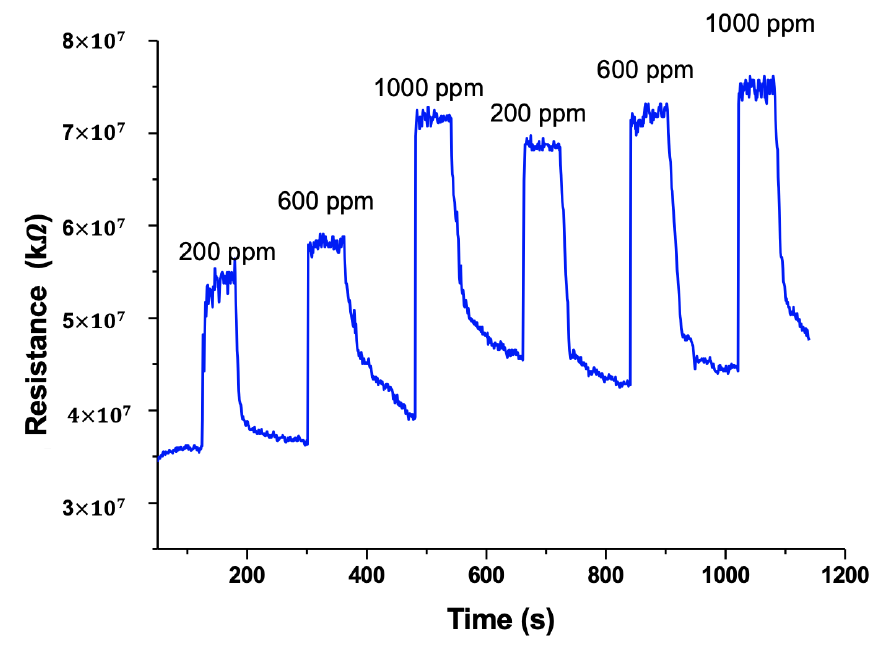
Figure 12. Two cycles of exposure of gCN sensor to CO 2 at 200, 600 and 1000 ppm concentrations at 40 °C.